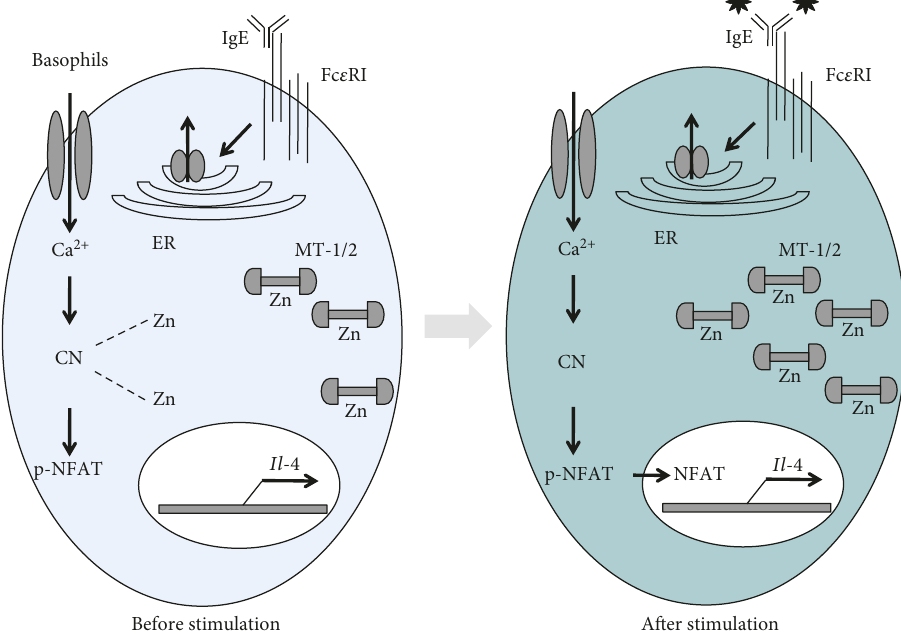
Figure 2: Metallothionein control in Fc ε R Ι -mediated IL-4 production in basophils. Fc ε R Ι stimulation activates basophils via signaling pathways that increase IL-4 production. Before stimulation, cytoplasmic free zinc ion inhibits CN. After Fc ε R Ι stimulation, cytoplasmic free zinc ion can induce the expression of metallothionein 1/2 and metallothioneins can bind to cytoplasmic free zinc ion. As a result, CN/NFAT signaling pathway can be activated and leads to increased IL-4 expression. IgE: immunoglobulin E; Fc ε R Ι : high-a ffi nity receptor for IgE; ER: endoplasmic reticulum; Zn: zinc; MT-1/2: metallothionein 1/2; Ca: calcium; CN: calcineurin; NFAT: nuclear factor of activated T cells; IL-4: